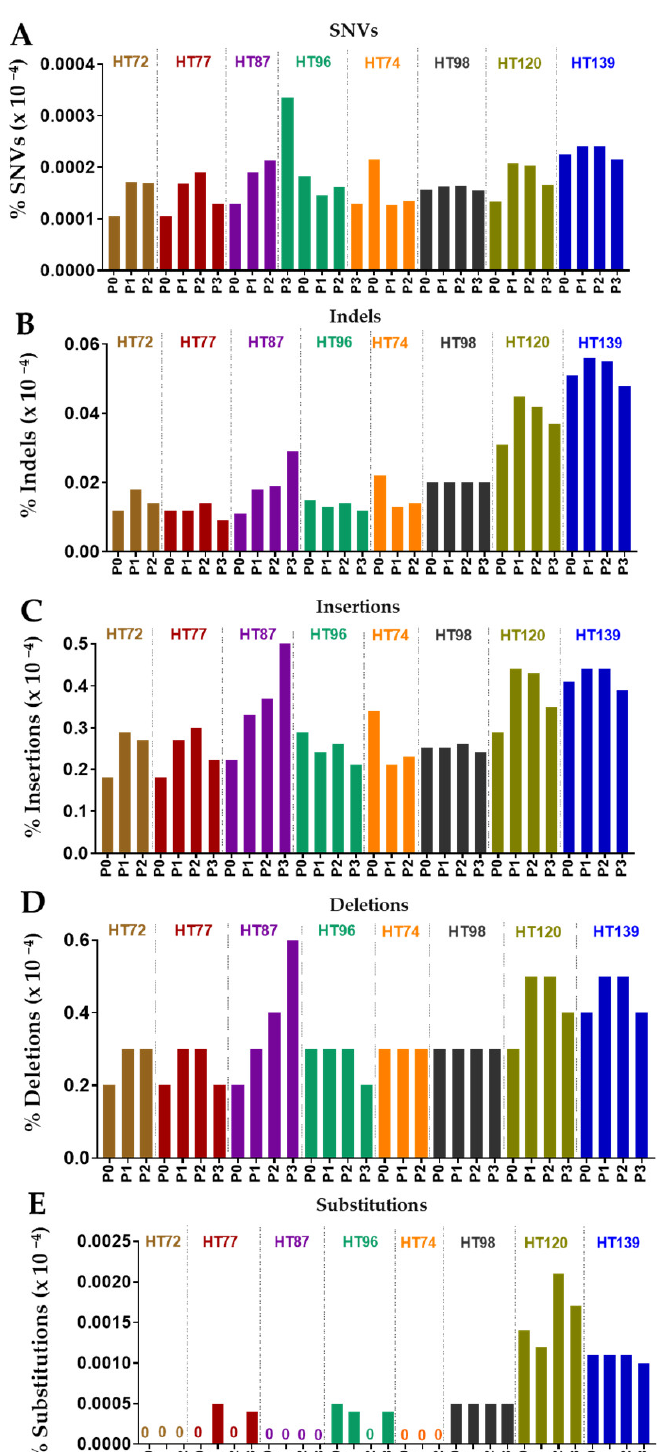
Figure 5. Total number of events identified in COSMIC genes as common variant classes such as